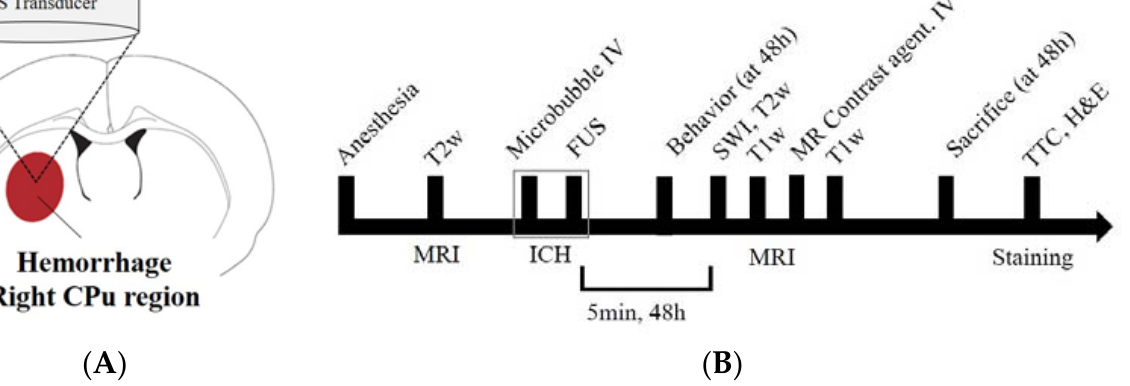
Figure 1. Experimental setup for focused ultrasound (FUS)-induced petechial hemorrhage and animal experimental design. ( A ) The intracerebral hemorrhage was targeted in the right caudate putamen (CPu) region for all FUS procedures. ( B ) Experimental design for investigating the FUS-induced ICH model. T2-weighted magnetic resonance (MR) images were obtained to locate the focal region before the sonication, and susceptibility weighted imaging, T2 and T1-weighted images and T1-contrast enhanced images were acquired for each time (5 min, 48 h) after the FUS. SD-rats were sacrificed and perfused for staining after 48 h after the FUS.